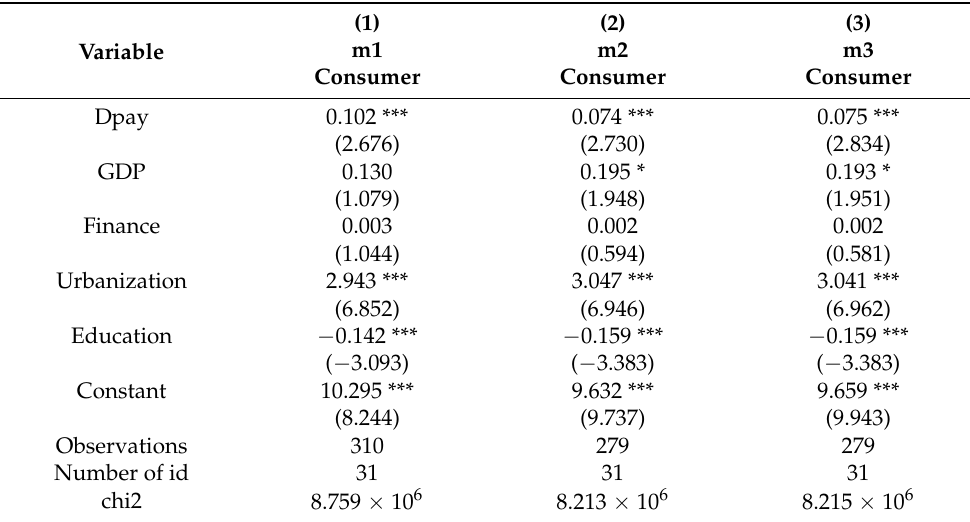
Table 6. Instrumental variable